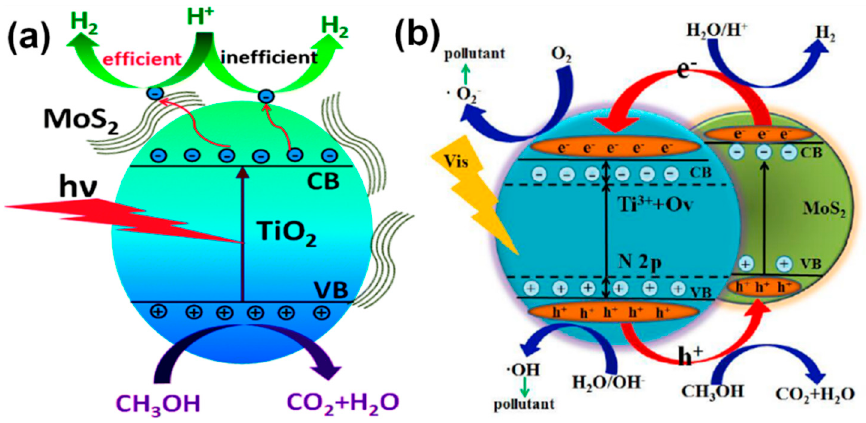
Figure 14. Photocatalytic charge transfer process in MoS 2 /TiO 2 under the irradiation of ( a ) UV light and ( b ) visible light (reproduced with permission from refs. [198,199]).